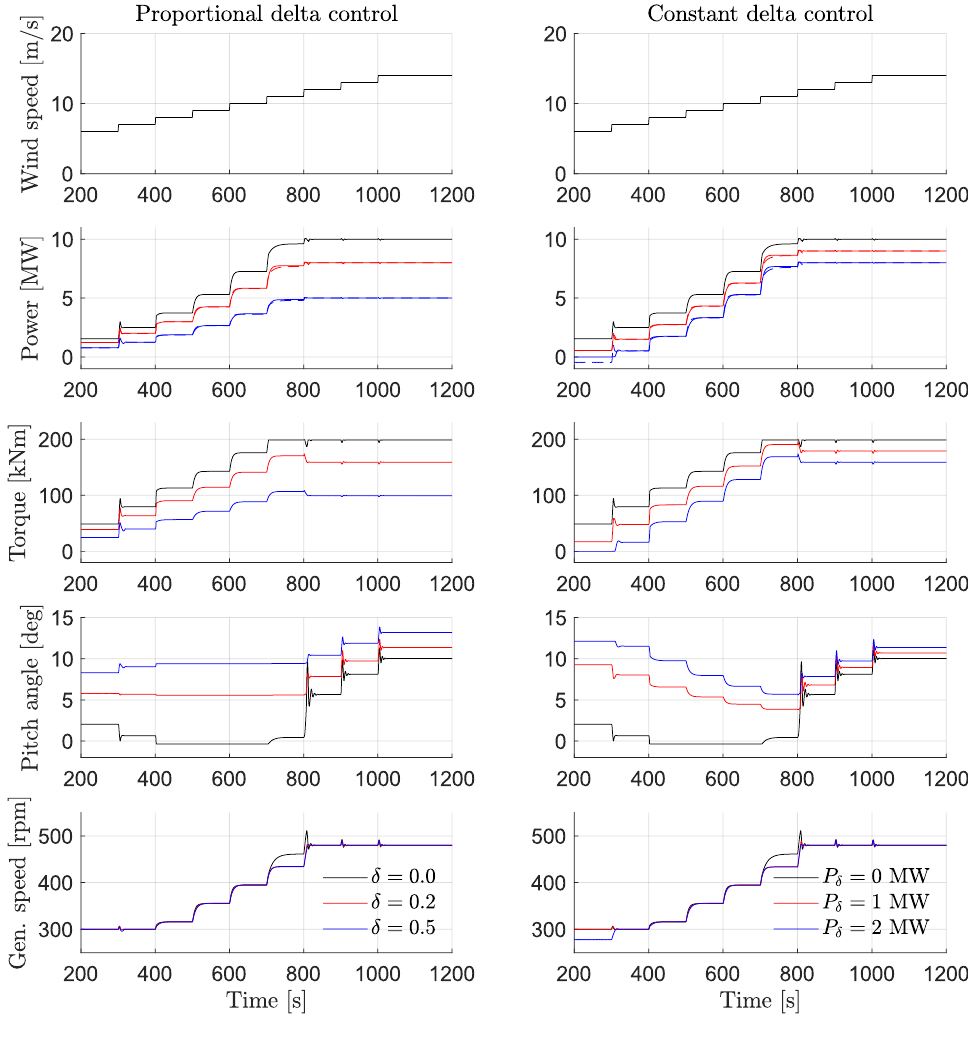
Figure 19. DTU 10-MW reference turbine with proportional and constant delta control, wind speed